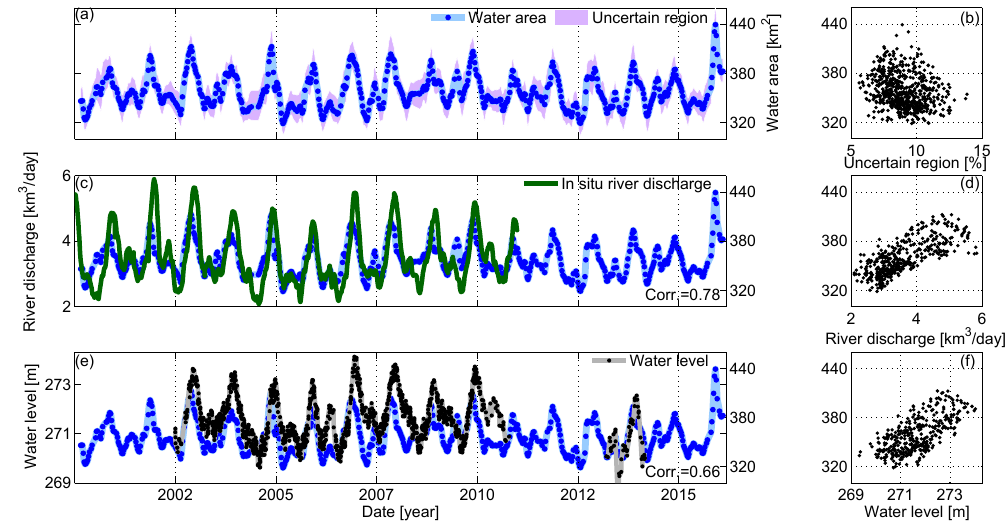
Figure 22. ( a ) Water area monitoring together with the uncertainty; ( b ) Scatter plot of water area vs. percentage of uncertainty; ( c , e ) Water area is plotted with in situ discharge and altimetric water level, respectively; ( d , f ) Scatter plots of simultaneous water area measurements against discharge and water level, respectively. Period of monitoring: February 2000–February